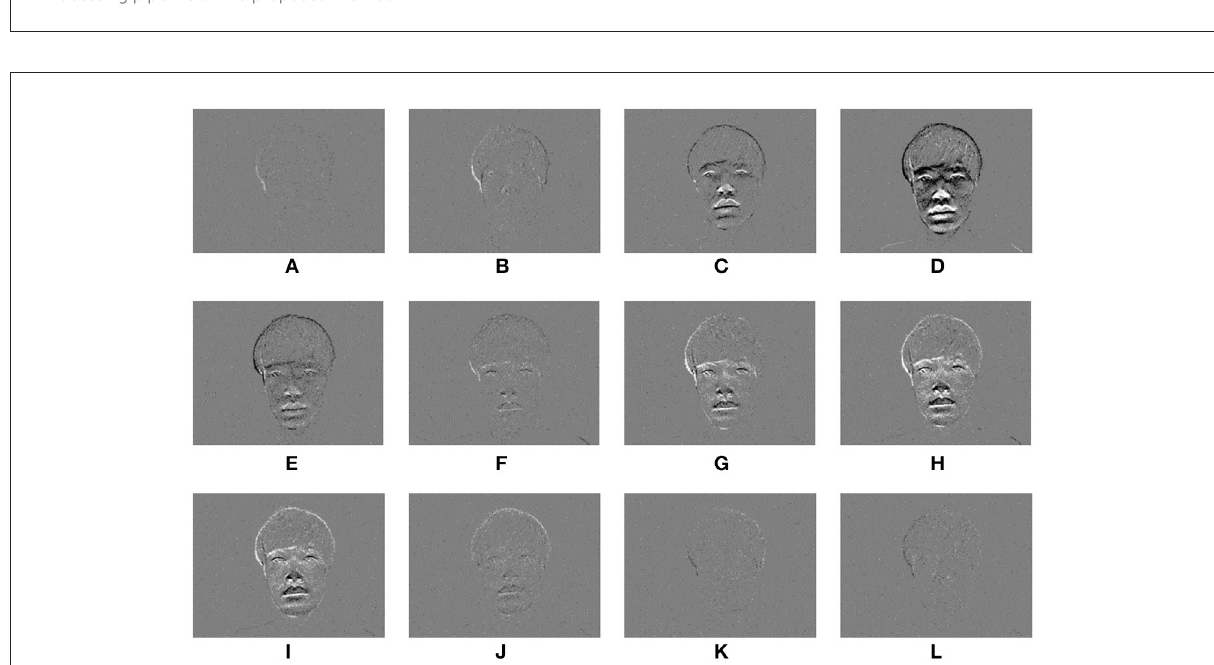
FIGURE2 Face images taken with an event-based camera during nodding. (A–L) are a time-series event images in one shooting scene.